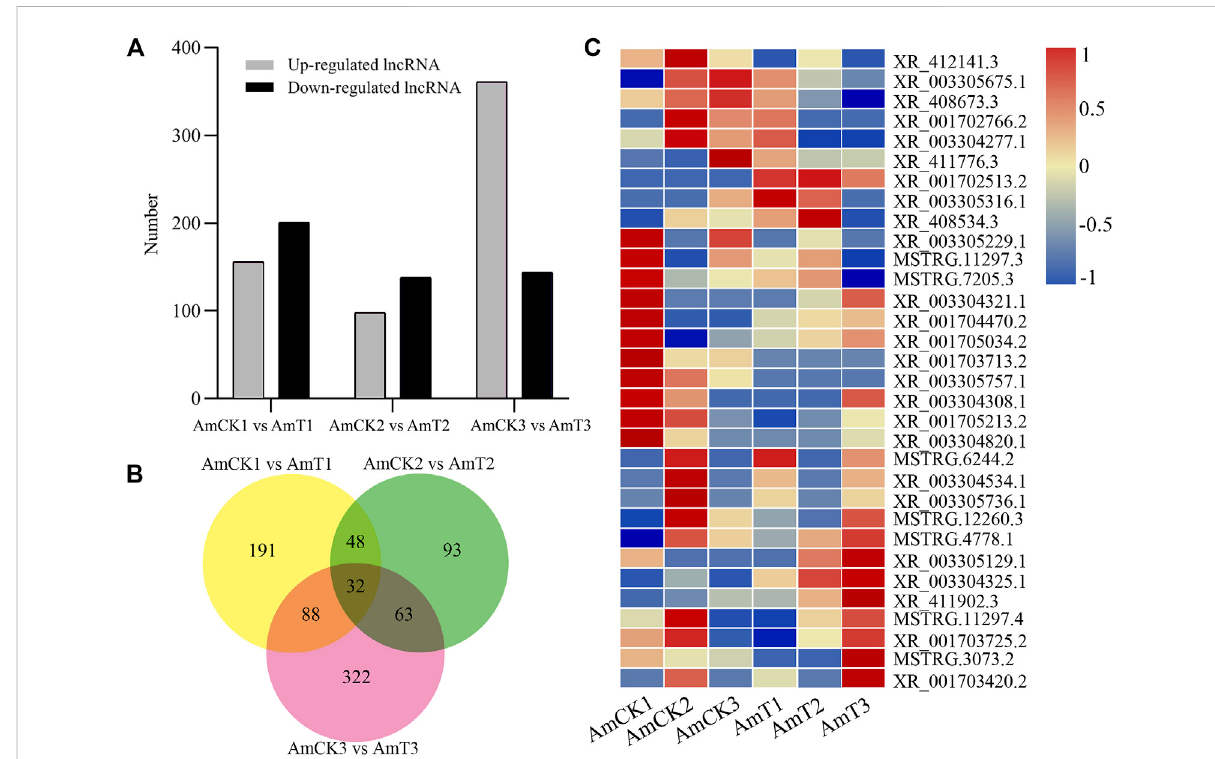
FIGURE 2 Number and expression of DElncRNAs in A.m. ligustica larval guts responding to A. apis infection. (A) Number of up- and down-regulated lncRNAs in three comparison groups. (B) Venn diagram of DElncRNAs in three comparison groups. (C) Heat map of shared DElncRNAs by three comparison